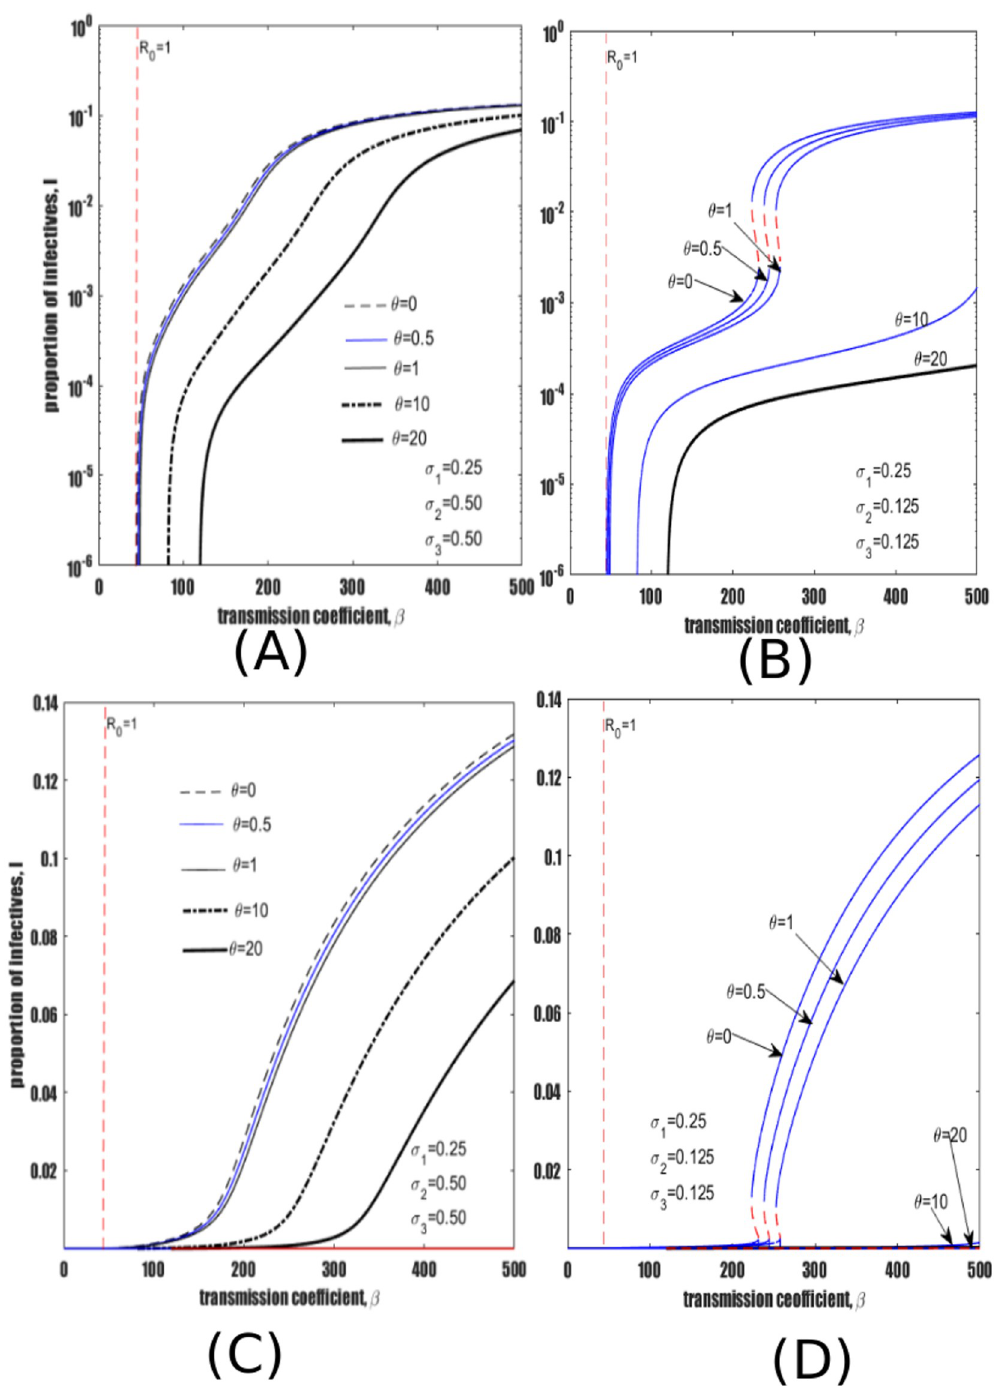
Fig 6. Impact of treating early latent individuals ( θ ) with IPT therapy under different risks of susceptibility to reinfection σ 1 . (A) Risks of reinfection among individuals treated with IPT and recovered individuals are greater than risk of reinfection of late LTBI. That is σ 2 , σ 3 > σ 1 . (B) The level of susceptibility to reinfection among late LTBI is lower than for both individuals treated with IPT and individuals treated from active TB. (C) and (D) respectively represents figures (A) and (B) plotted in linear scale. Treatment of late LTBI and individuals with active TB are respectively set at ρ = 0.1 and τ = 2 while other parameters are as shown in Table